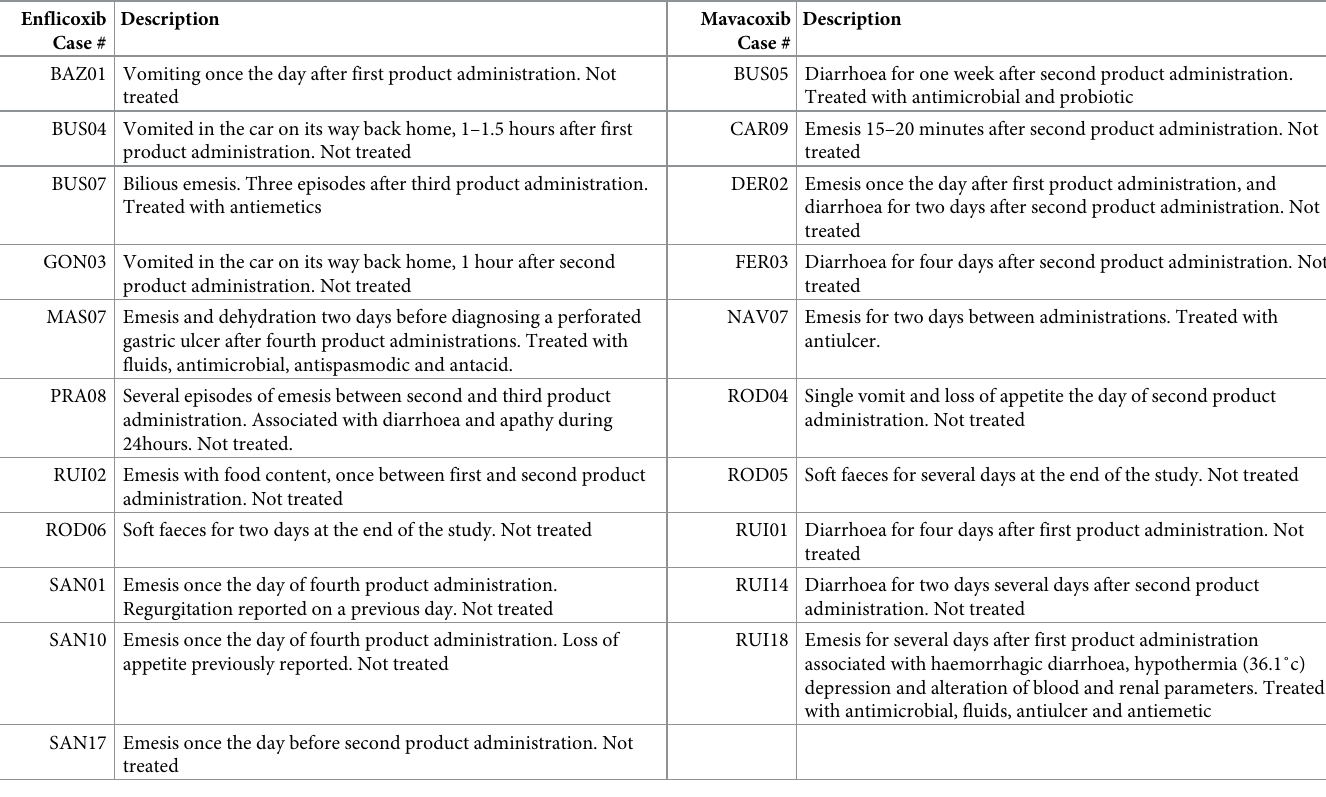
Table 3. Digestive tract disorders reported as AE, classified as A, B or